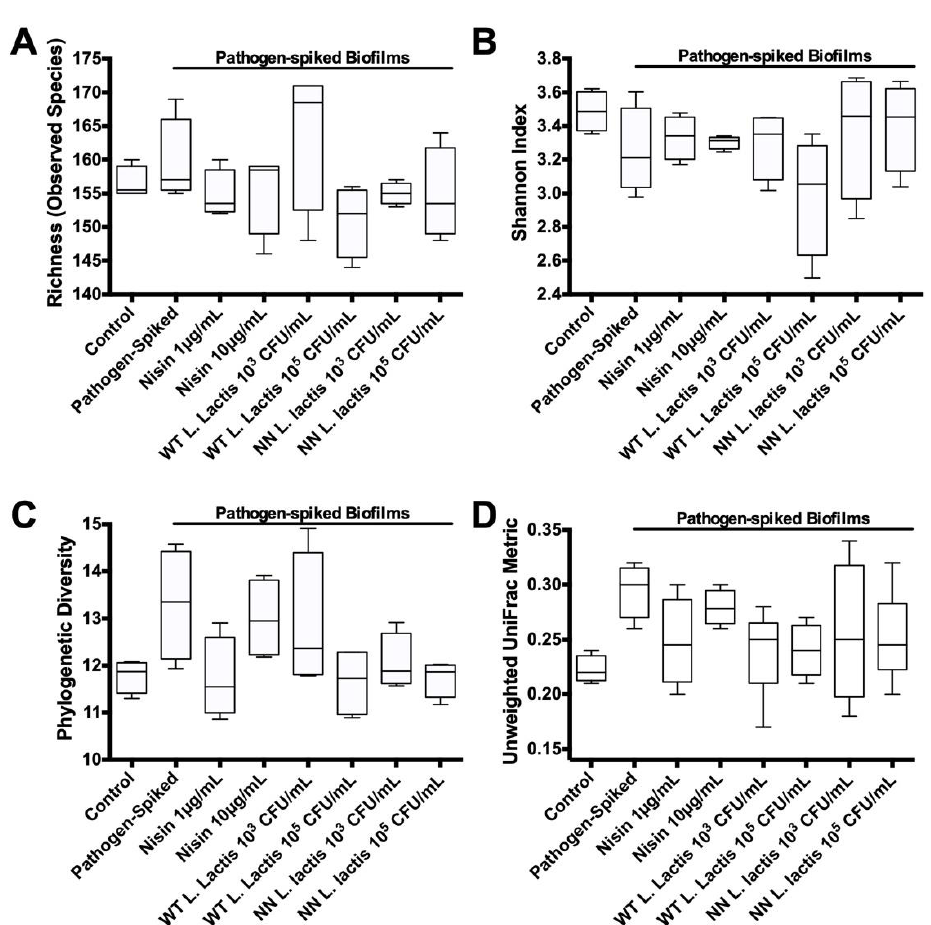
Figure 7. Nisin and probiotic show a tendency to revert pathogen-spiked biofilm richness and diversity indices back to control levels. ( A ) Species richness (number of observed species); ( B ) Shannon diversity index; ( C ) phylogenic diversity index; ( D ) unweighted UniFrac metric.